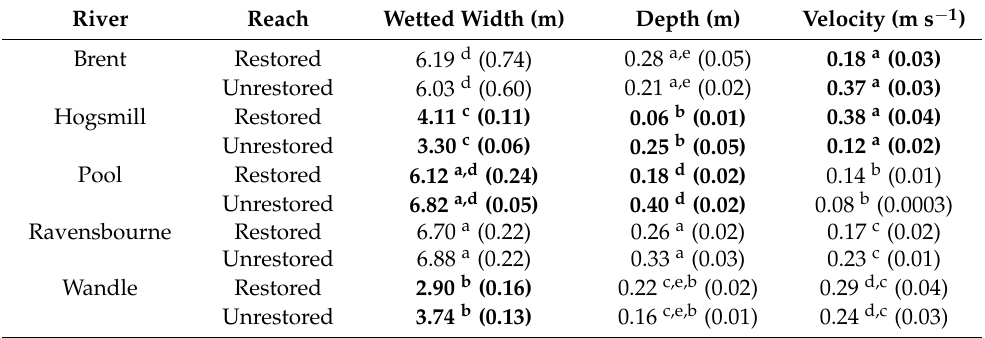
Table 2. A summary of physical habitat characteristics across the study rivers. Measurements were made after fish collections at each study reach (wetted width ( n = 5), depth ( n = 25) and velocity ( n = 25); (see [42] for detailed methods). Values in parentheses denote one standard error. Significant differences between restored and unrestored reaches are in bold; differences among rivers are indicated by letter groupings (i.e., the same letters displayed denote no statistical differences between rivers, while different letters denote statistical differences between rivers). These physical habitat characteristics did differ across the study rivers and between select restored and unrestored reaches but still provided conditions that satisfied the requirements for resident fish species [40]. Physical habitat characteristics across the sites during the study period are provided in Supplementary Materials, Table